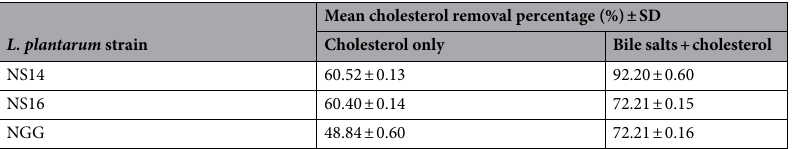
Table 1. Cholesterol removal capability of L. plantarum strains in cholesterol containing medium with and without bile salts. The mean of three values ± SD are presented.